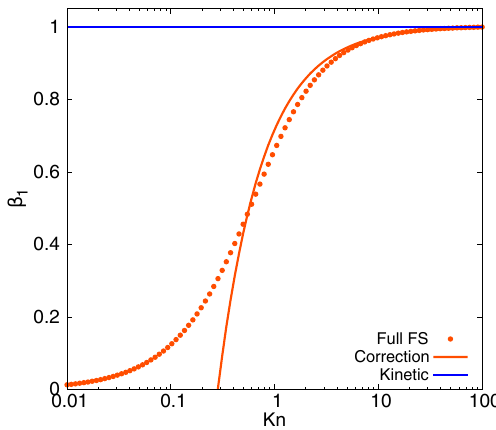
Figure 1. Fuchs–Sutugin coefficient as compared to its one-term (kinetic) and two-term (correction) expansions at small 1 / Kn